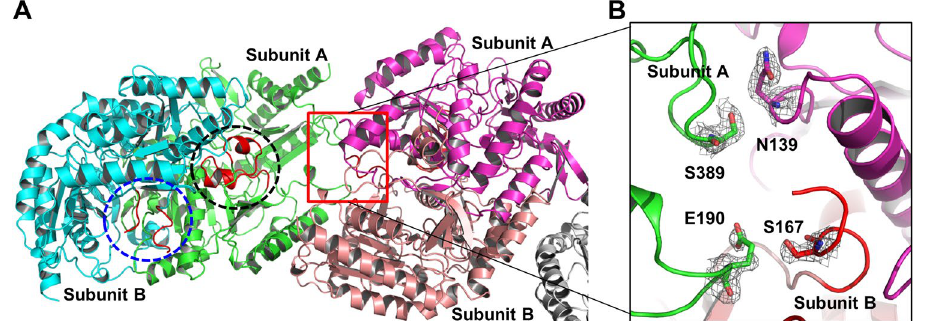
Figure 6. The position of α 6/ α 7 helix that contains Y165 and N166. ( A ) The structure of dimeric apo Vfat (green and cyan color) with one of the neighboring molecules in crystal packing (magenta and pink color). The α 6/ α 7 helix regions that contains Y165 and N166 are boxed with black-dotted circle (subunit A) and a blue-dotted circle (subunit B). ( B ) The crystal packing interface formed by subunit A and the unwound α 6/ α 7 helix domain in subunit